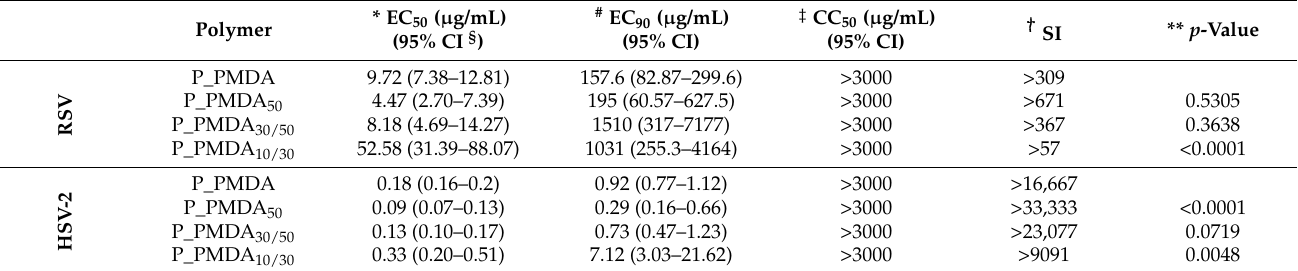
Table 3. Antiviral activity of P_PMDA and its fractions against RSV and HSV-2. Table 2. Antiviral activity of β CD-based polymers against RSV, HSV-2, FluVA, and HRoV.